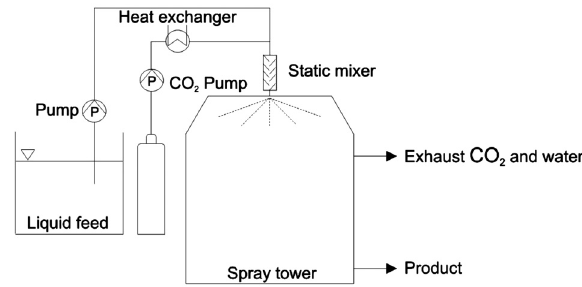
Table 3. – Spray drying process parameters